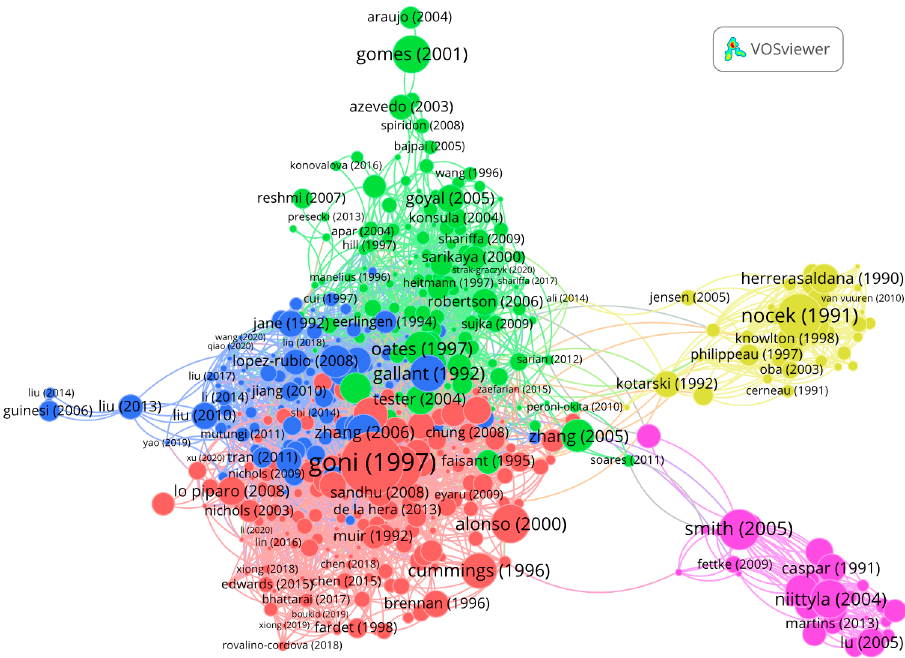
Figure A3. Citation network visualization of the 500 articles of the panel with 3195 links and 5 clusters. The article with the highest number of links (96) is Goñi et al., (1997). Size of nodes reflects the number of citations.